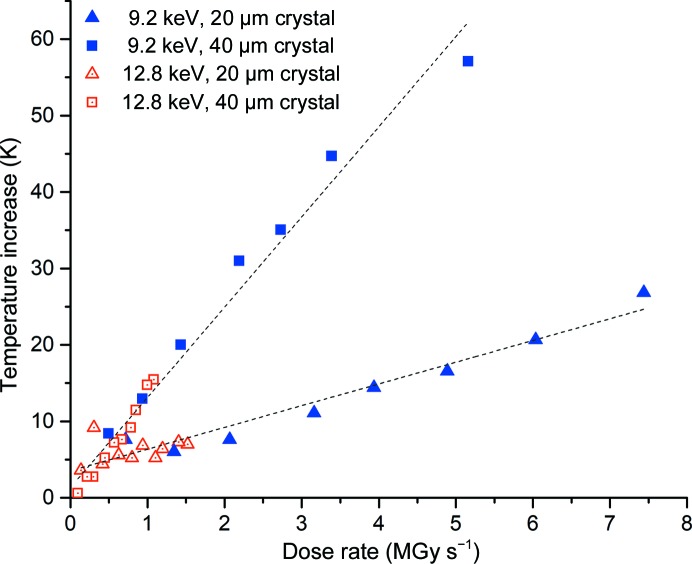
The effect of dose rate on the temperature increase of ruby crystals. Blue and red points indicate data collected at 9.2 and 12.8 keV, respectively. Data collected with the crystal size matched to the beam are shown as triangles; squares indicate that the crystal was larger than the beam.